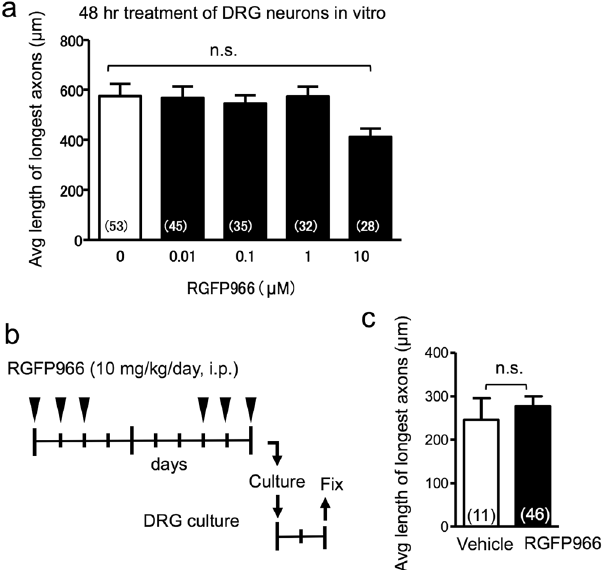
Figure 5. HDAC3 inhibition does not affect axon growth potential. ( a ) Dose-response neurite outgrowth assays show that RGFP966 treatment of cultured DRG neurons for 48 hr does not increase average length of longest axon. p = 0.073, Kruskal-Walis test. ( b , c ) Schematic diagram of in vivo RGFP966 treatment followed by DRG culture ( b ). No significant changes were observed for average axonal length between the two groups ( c ). unpaired Student’s t test. n.s. not statistically significant. The numbers of DRG neurons quantified are shown inside each bar